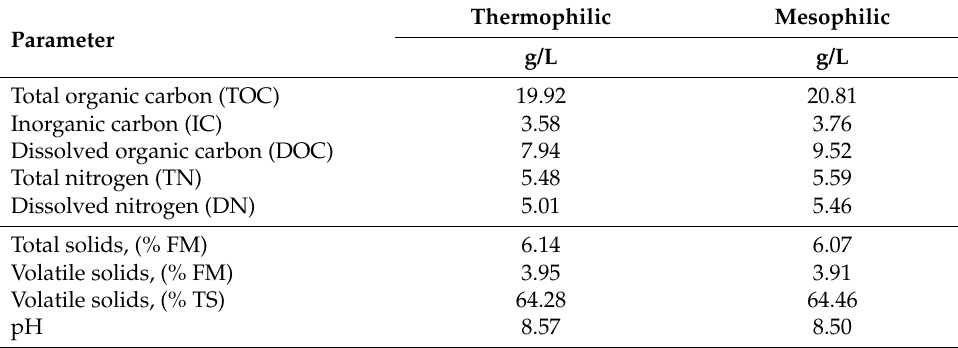
Table 1. Characteristics of the inocula (after mixing and degassing).